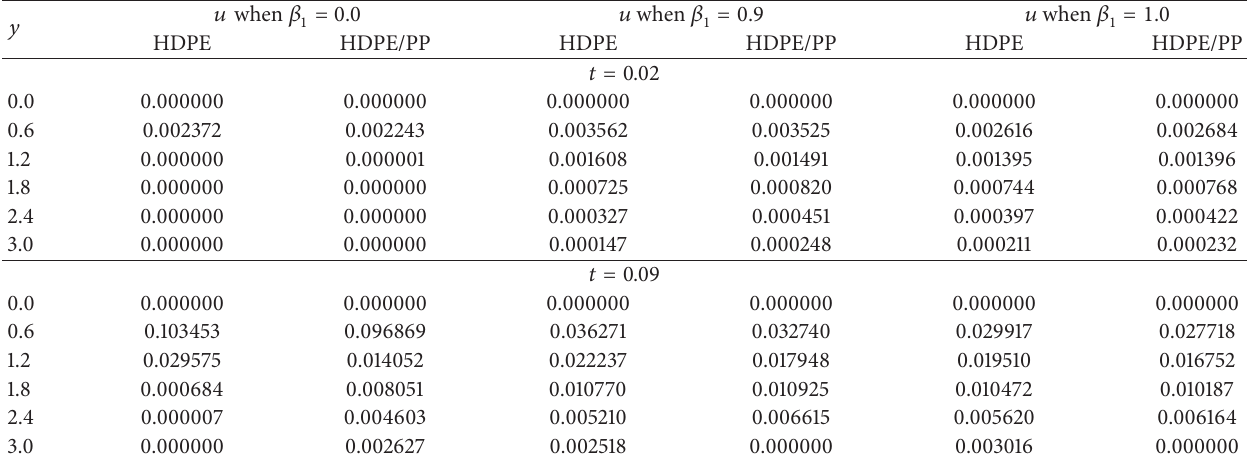
Table 5: Velocity values of HDPE and HDPE/PP fluids for different 𝛽 1 when 𝛼 1 = 𝛼 2 = 𝛽 2 = 1 ; 𝑡 = 0.02, 0.09 .